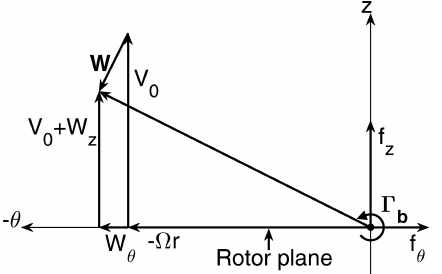
Figure 1. Cross-section of blade element showing velocity and force vectors. The blade is pointing out of the paper, and the consid- ered cross-section is located at the origin of the coordinate